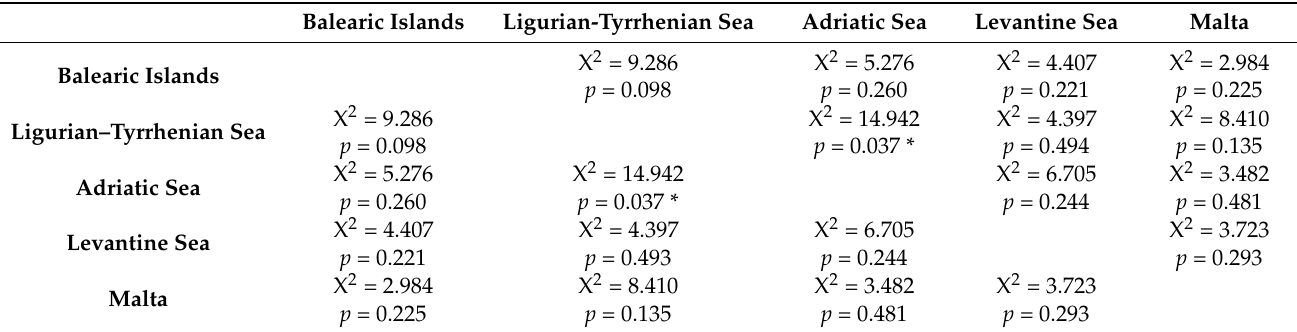
Table 2. Results of the genetic differentiation analysis (Chi-squared) for the COI (Cytochrome C Oxi- dase subunit I) mitochondrial gene fragment between populations of Raja clavata in the Mediterranean Sea. X 2 : Chi-squared estimates; p : p -values; *: statistical significance.